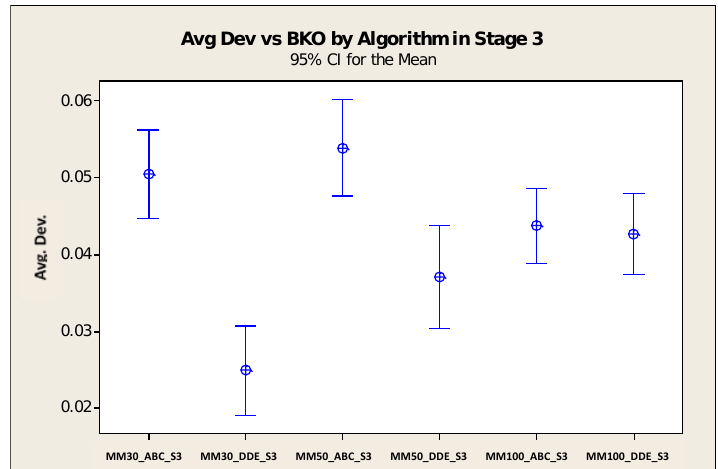
Figure 5. Avg dev vs. BKO CI for each algorithm in Stage 3 (MRCPSP/max).